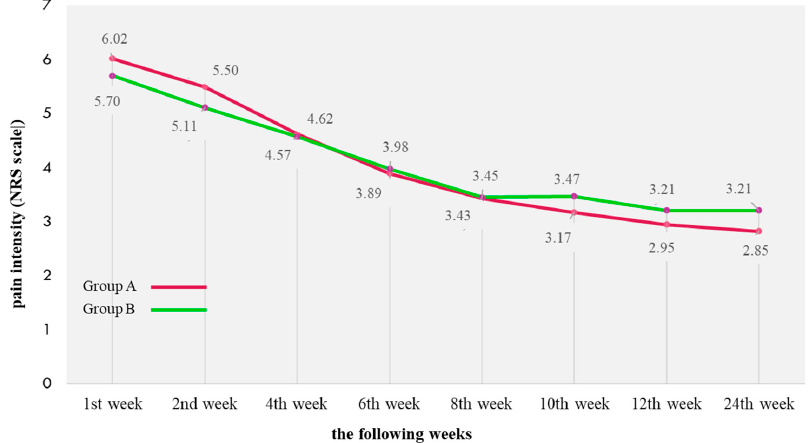
Figure 3. Changes in pain intensity on the NRS scale in the consecutive weeks of observation. Correlation between wound area and pain intensity (NRS scale): R (Group A) = 0.152, p = 0.005; R (Group B) = 0.29, p = 0.001. Correlation between wound healing progress and changes in pain intensity (NRS scale): R (Group A) = 0.79, p = 0.001; R (Group B) = 0.59, p = 0.001. R—Spearman’s rank correlation coefficient; (A)—group A; (B)—group B; p —value.